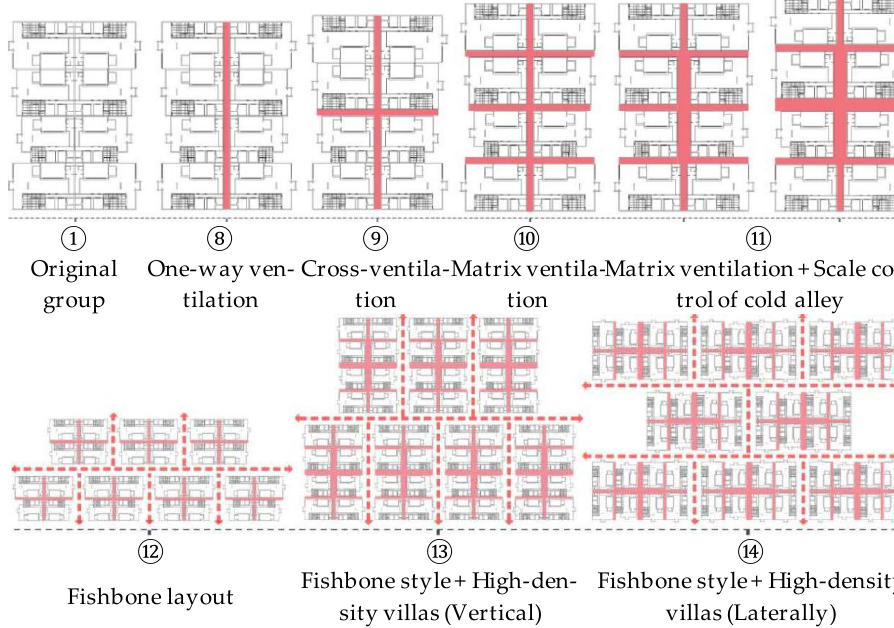
Figure 9. Planar grouping optimization process.